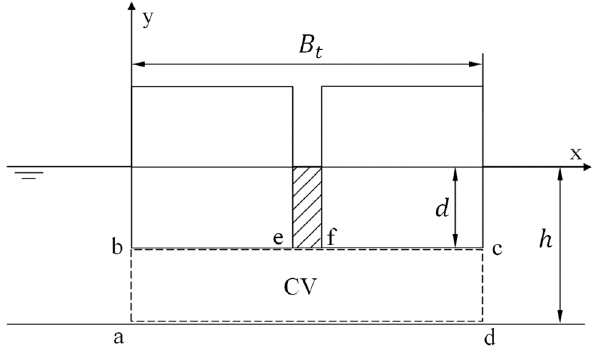
Figure 13 . The sketch of the control volume below the twin squares. Figure 13. The sketch of the control volume below the twin